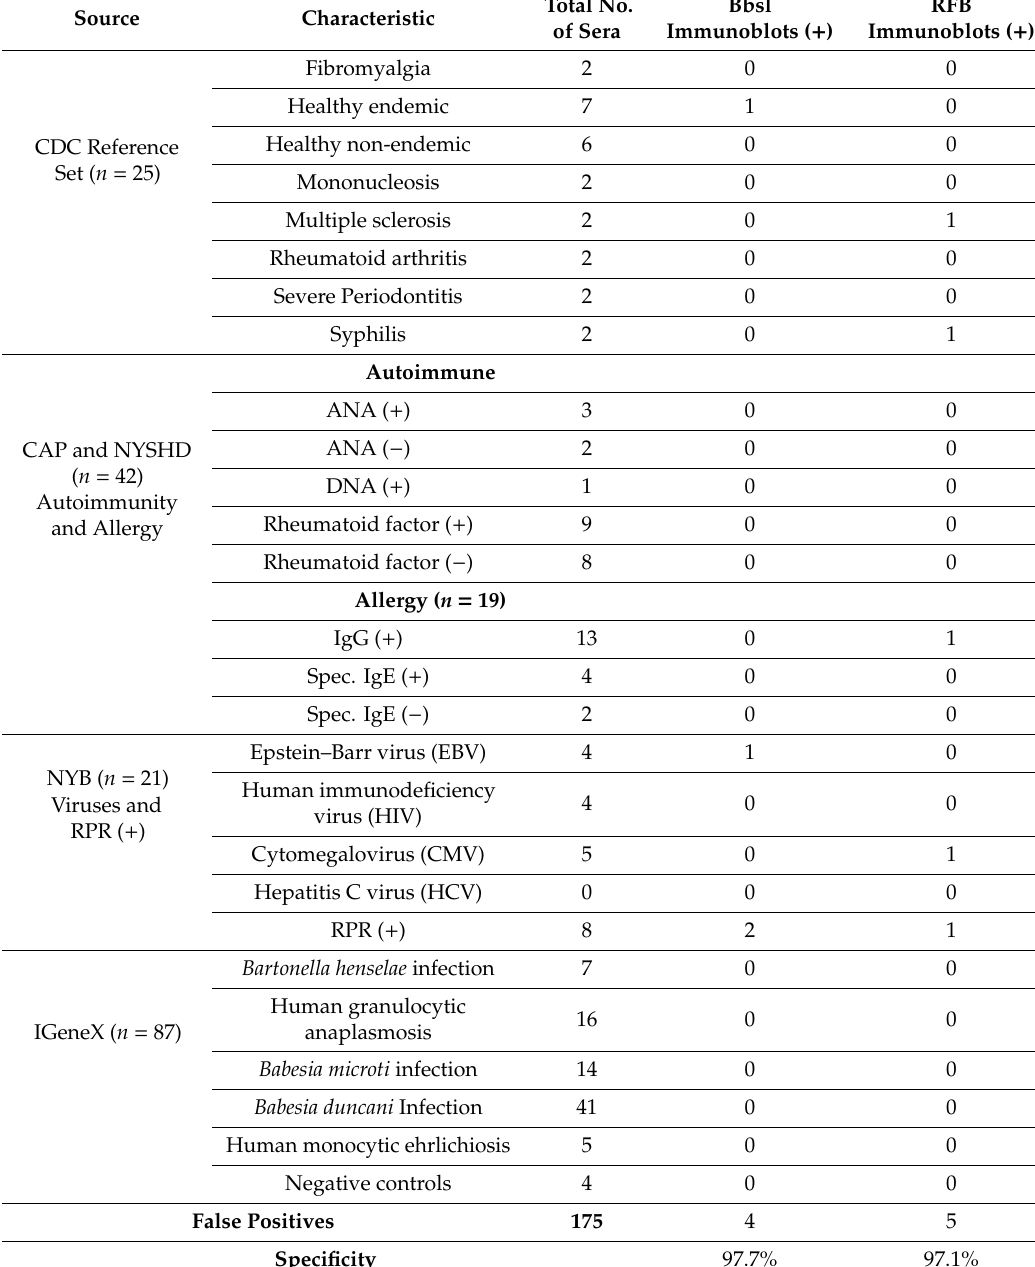
Table A3. Reference human sera for determining the specificity of Bbsl and RFB